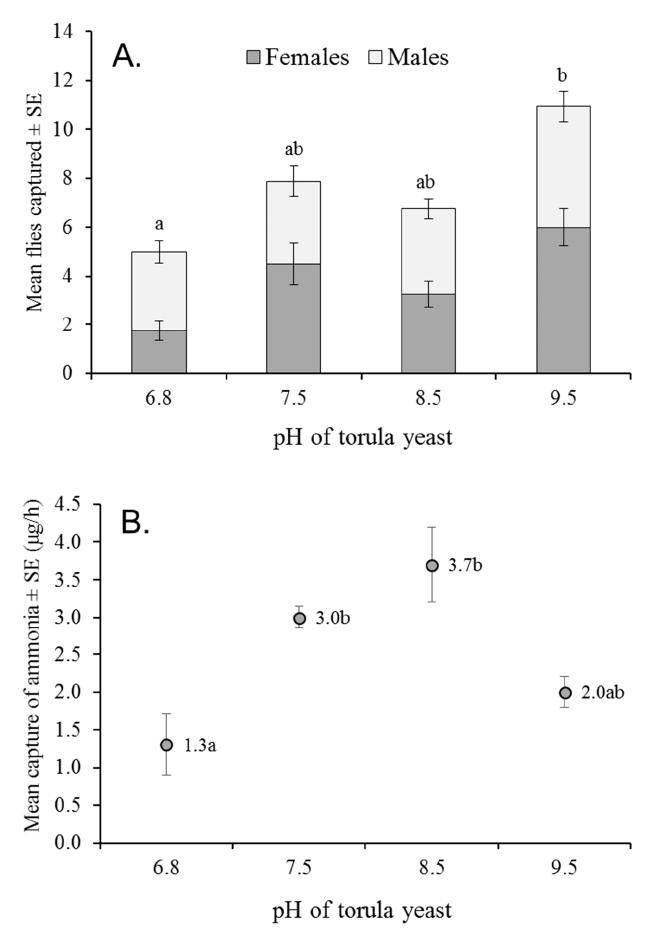
Figure 3. ( A ) Mean numbers of A. obliqua males and females captured in traps baited with 1% torula yeast (pH 6.8) or 1% torula yeast alkalized to different pHs. ( B ) Mean quantities of ammonia released by untreated torula yeast or alkalized torula yeast at different pHs. Total flies captured (males + females) in ( A ) and pH values in ( B ) labeled with the same letter do not differ signifi- cantly (ANOVA, Tukey, p > 0.05).